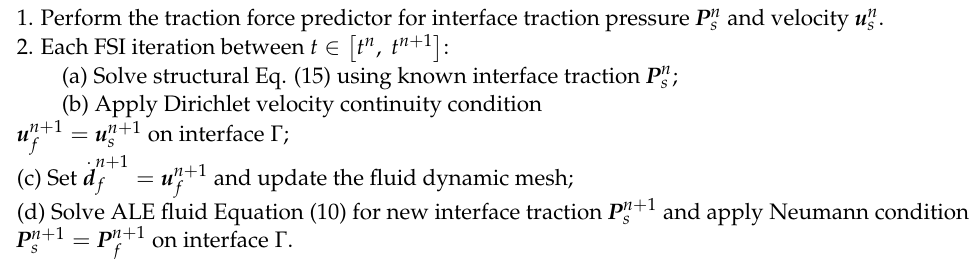
Algorithm 1. Partitioned coupling